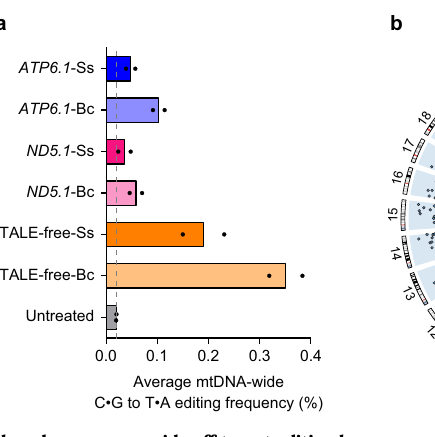
b Genome-widecircosplotsrepresentingthedistributionand Detect-seq scoresof identi fi ed nuclear DNA off-target sites on each chromosome for three different DdCBEs. The number of off-target sites is shown in parentheses. Source data are provided as a Source Data fi